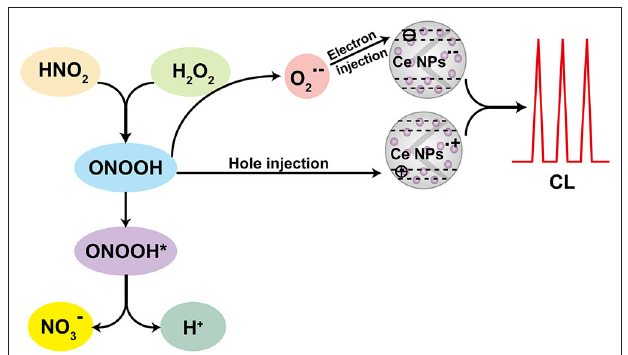
FIGURE 5 | Schematic illustration of the CL mechanism of the LaF 3 :Ce NPs-NaNO 2 -H 2 O 2 system.